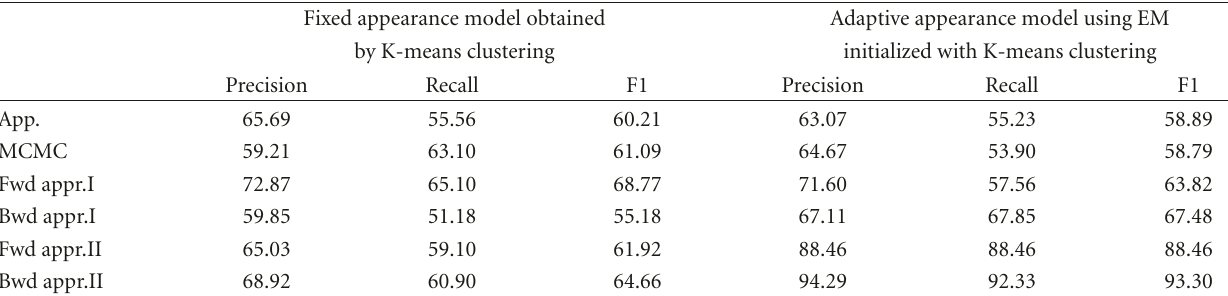
Table 6: Data association accuracy of di ff erence algorithms